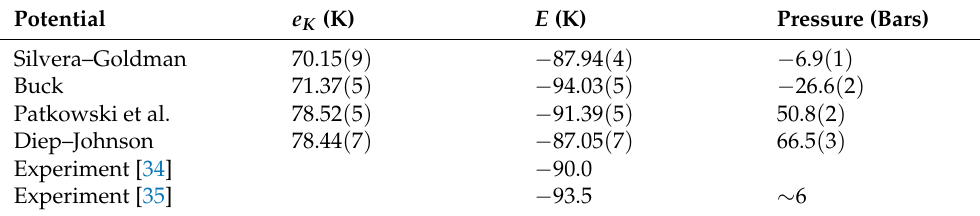
Table 2. Simulation results for the kinetic ( e K ) and total ( E ) energy per molecule (in K), and for the pressure (in bars) in the crystal (hcp) phase of p -H 2 at temperature T = 4 K and den- sity n = 0.0261 Å − 3 , computed using different intermolecular pair potentials. Statistical errors (in parentheses) are on the last digit. Also shown are experimentally extrapolated values for the ground state energy [34,35], as well as the value of the pressure at T = 4 K, obtained by interpolating data in Table III of Ref. [35].